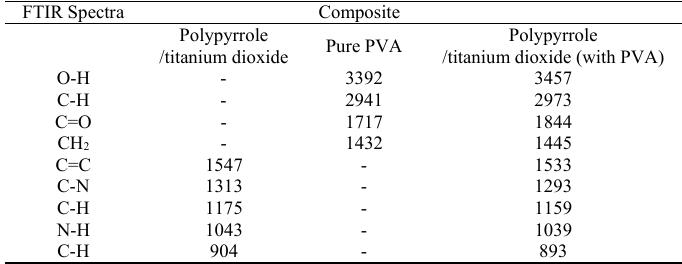
Table 2: FTIR spectra of polypyrrole/titanium dioxide with and without